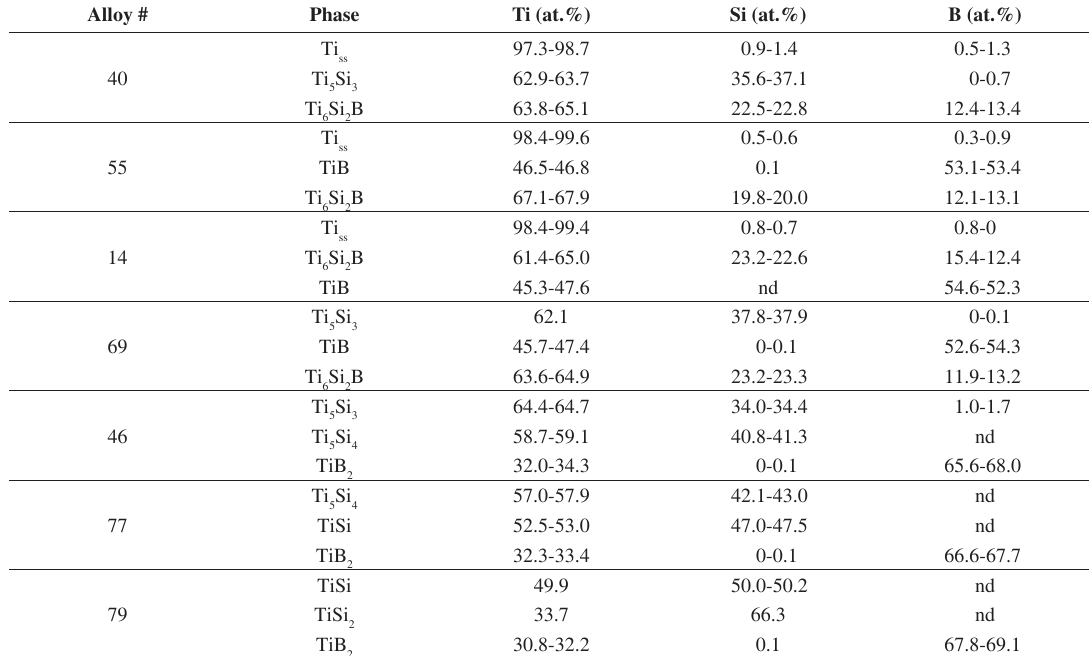
Table 2. Ti, Si and B contents of the phases present in the Ti-Si-B alloys measured by WDS analysis. Note that the composition ranges correspond to the minimum and maximum measured values. Alloy #